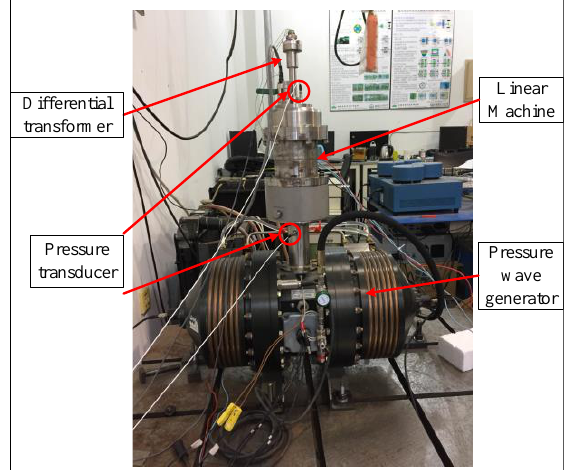
Figure 13. Test platform photo of power generating system.